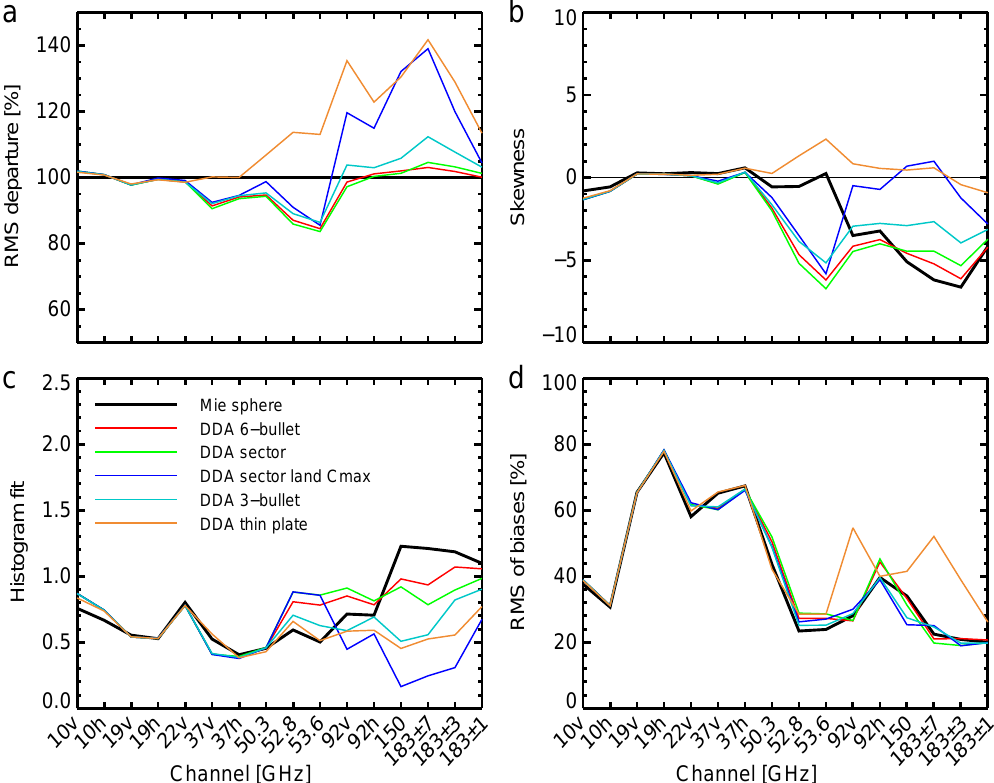
Figure 11. Measures of fit between model and observations over land surfaces: (a) The rms of FG departures, normalised by the Mie sphere results; (b) skewness of FG departures; (c) brightness temperature histogram fit; (d) rms of mapped